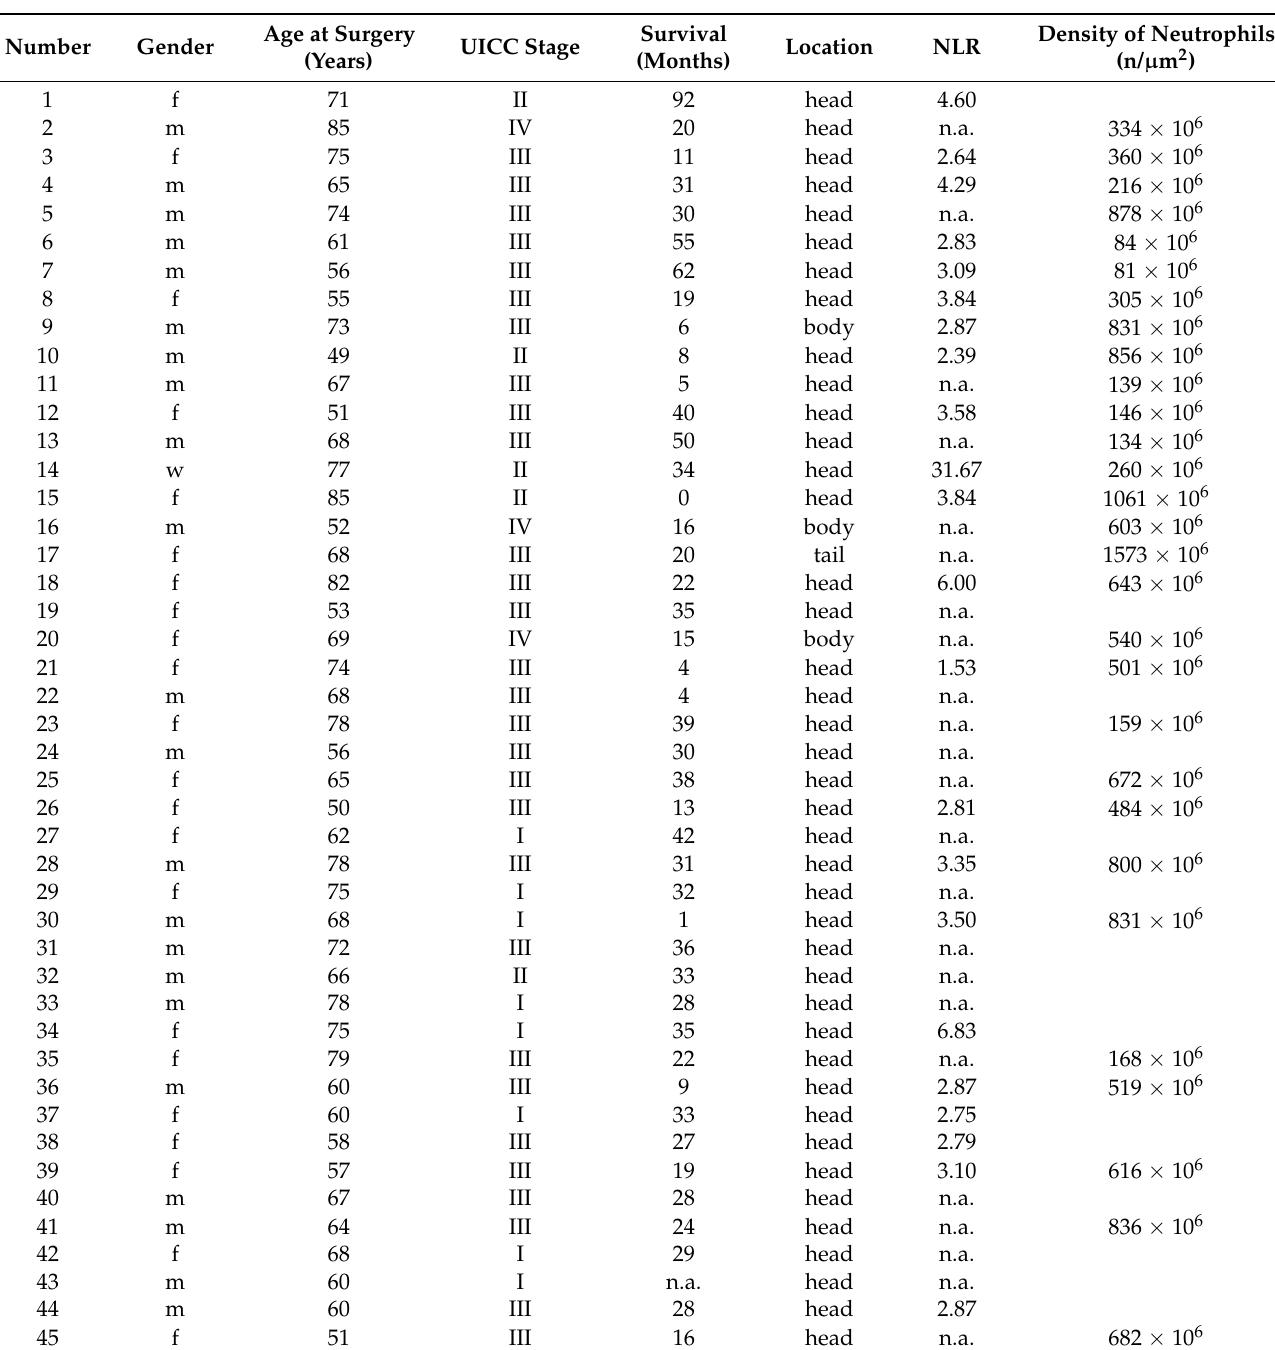
Table A1. Summarizes clinical data and neutrophil counts in venules of PDAC patients in the cohort